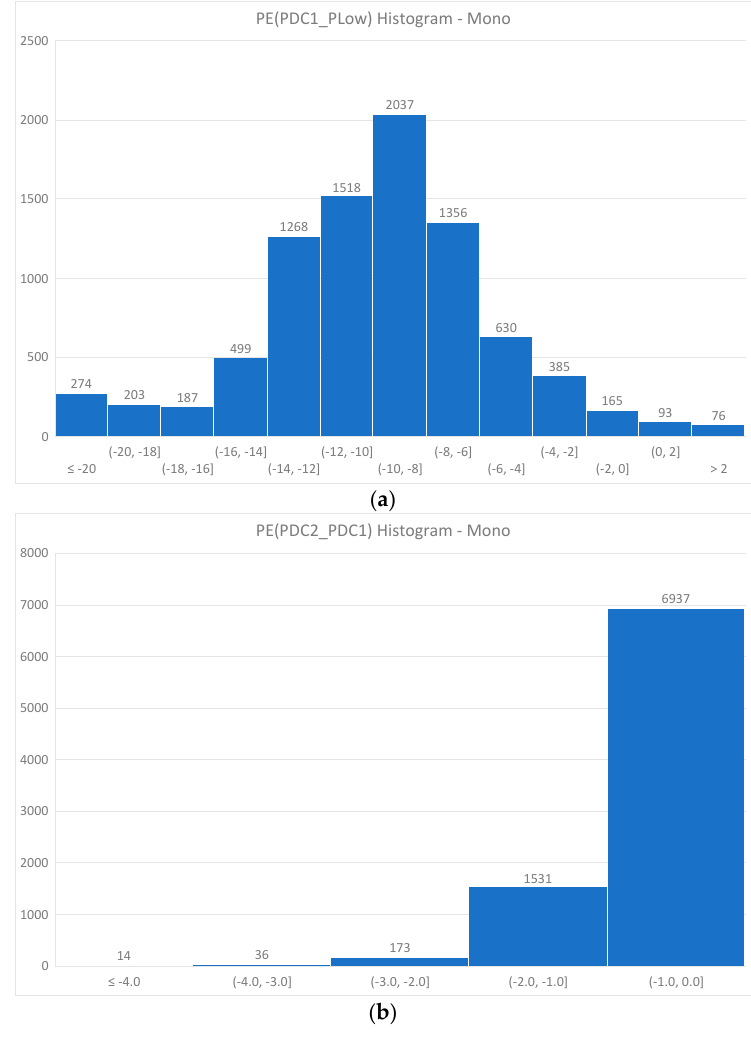
Figure 7. Histograms of the Percentage Error PE Low concerning PDC Low and P Low ( a ), and the Percentage Error PE Low concerning PDC Low and PDC Low ( b ); monocrystalline modules. Table 2. Mean Absolute Percentage Error ( MAPE ) for monocrystalline, polycrystalline, and thin-films modules, under Normal Operating Conditions (NOCs). MAPE NOC